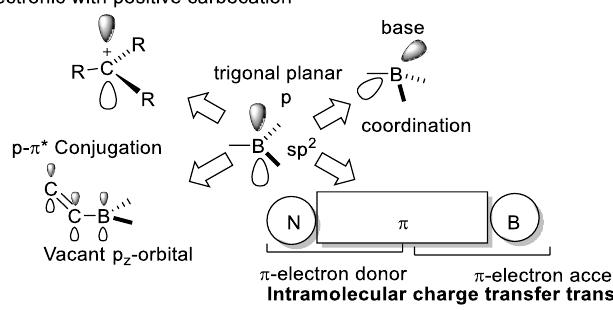
Figure 8. Boron forming an adduct with nitrogen.